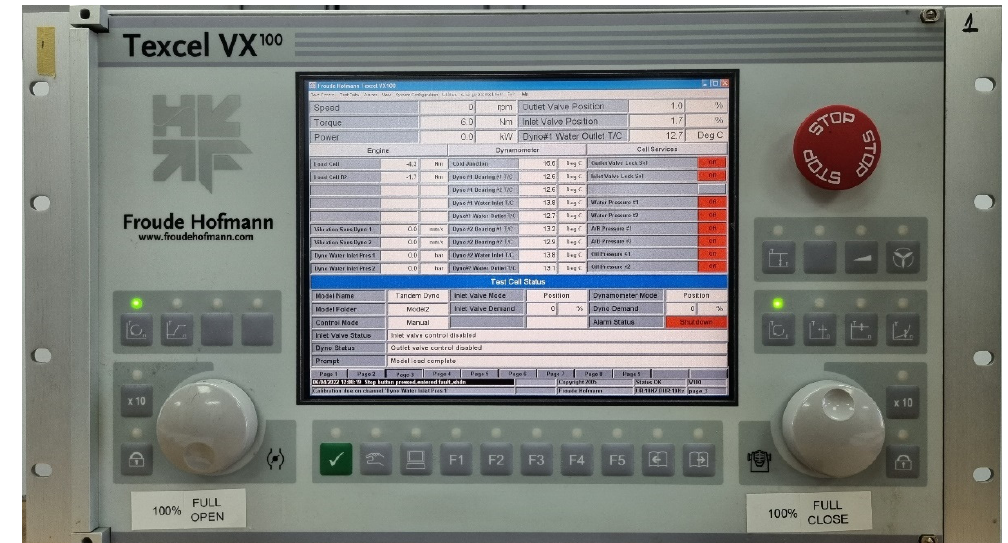
Figure 7. User interface of dynamometer operating system.